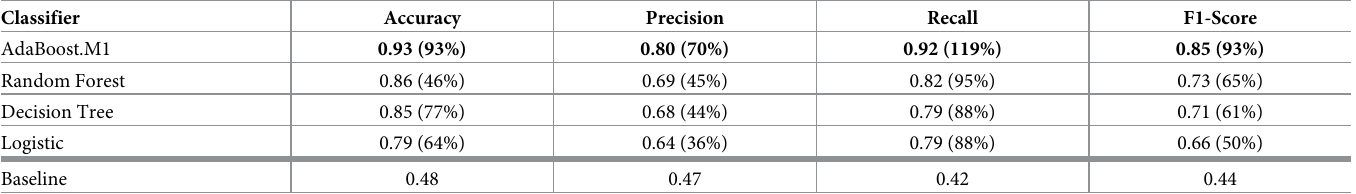
Table 4. Table of the leave-one-team out cross-validation results (i.e., accuracy, precision, recall and F1-score) computed on the training dataset of each machine learning classifiers used to predict a football team in a game as male ( class 0 ) or female ( class 1 ). The baseline classifier always predicts by respecting the training set’s class distribution, which is balanced. The percentages in the table refer to the improvement of machine learning model compared to the baseline results. Classifier Accuracy Precision Recall F1-Score